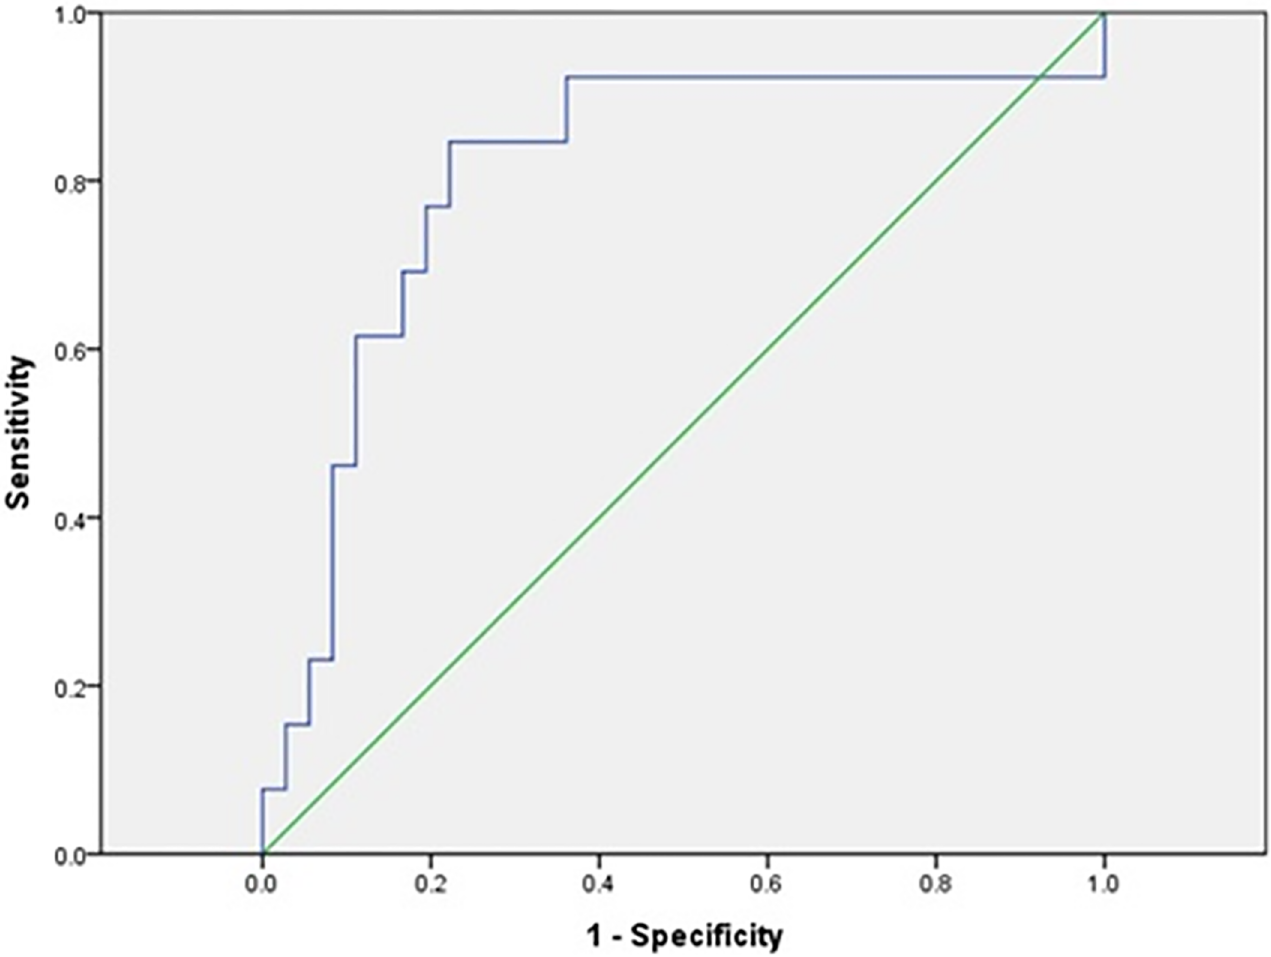
Fig 2. Combined receiveroperating characteristic curve of the % change of SPP during CPB for the postoperative 6 h hyperlactatemia (peak lactate > 3mmol/L). An area of 0.808 (95% confidenceinterval of 0.652–0.963,P = 0.001) was observedbelow the line of % change in SPP value. The optimal cutoff value for postoperative 6 h hyperlactatemia was 48% decreasefrom the baselineSPP (after inductionof anesthesia), with a sensitivity and specificity of 84.6% and 77.8%, respectively.SPP = skin perfusion pressure; CPB = cardiopulmonary bypass.